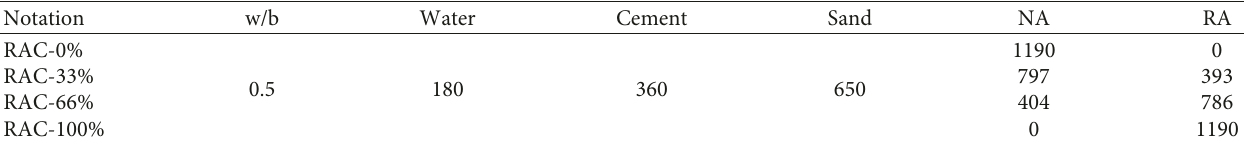
Table 2: Mix proportions of RAC (kg/m 3 ).